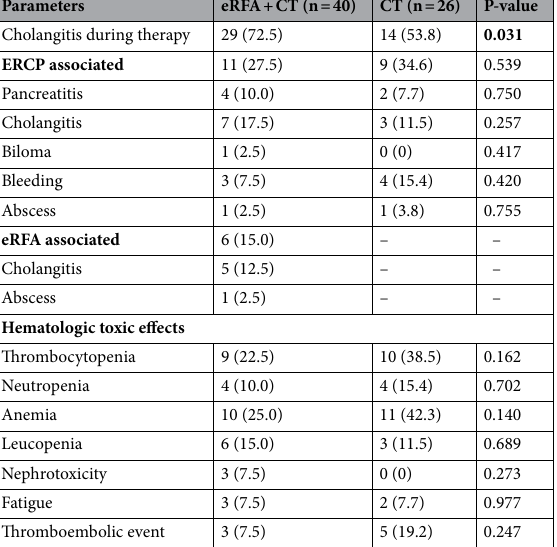
Table 4. Adverse events. Data are presented as absolute frequency with relative frequency in parentheses. Adverse events were registered if they required intervention or adaptation of therapy (CTCAE v4.0, grades 3–5). ERCP endoscopic retrograde cholangiopancreatography, eRFA endobiliary radiofrequency ablation. P values refer to Chi-squared test or Fisher exact performed between groups eRFA + CT and